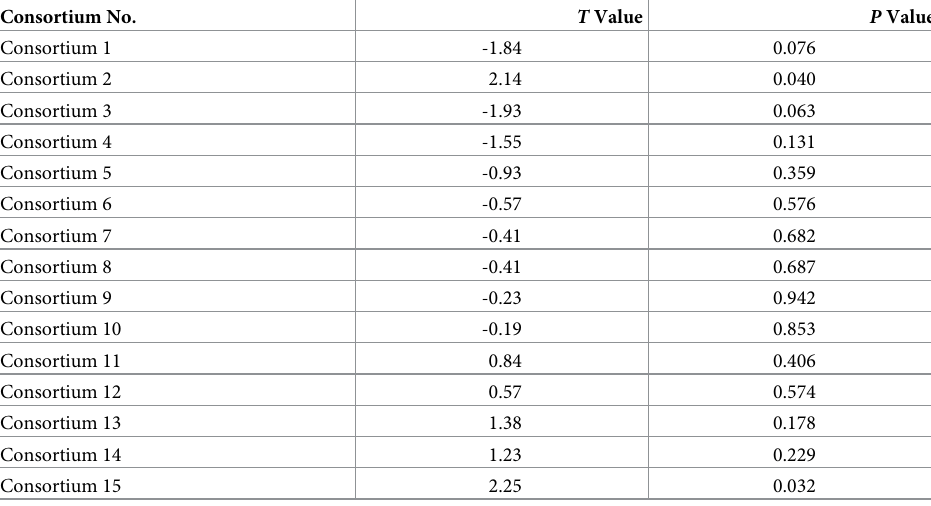
Table 6. ANOVA of fungal consortium producing lignin peroxidase. Consortium No.